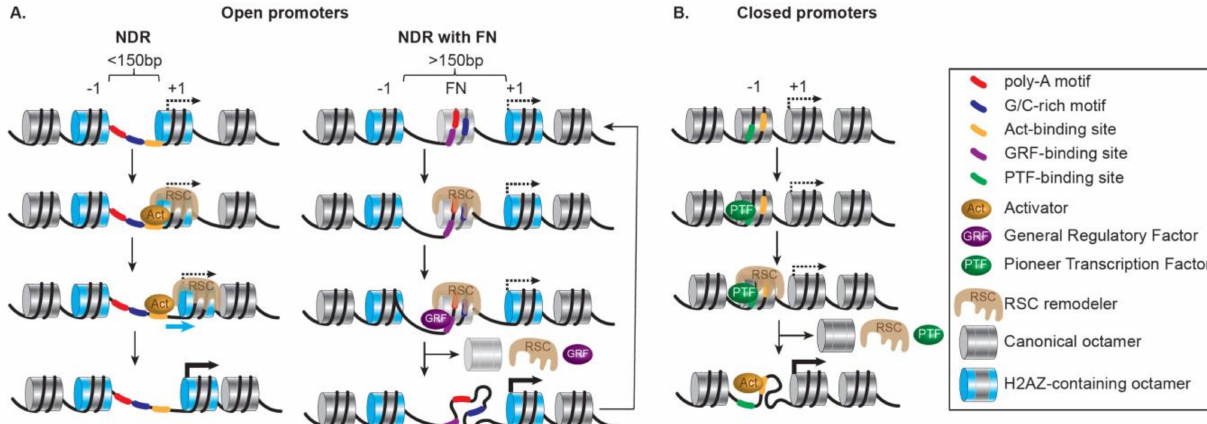
Figure 5. Promoter architectures and nucleosome occupancy impact how remodelers are recruited. For adequate regulation, most genes in yeast blend features from two types of promoter architectures. ( A ) Open promoters, in their repressed state, present an NDR without (left) or with (right) a fragile nucleosome (FN) adjacent to the TSS (black arrow), containing poly-A and G/C-rich motifs, along with activator/GRF-binding sites, and flanked by well-positioned H2A.Z-containing nucleosomes, leading to regular spacing and phasing in a genome population. Open promoters are common at constitutively active genes, and their activation necessitates minor (if any) remodeling (+1 nucleosome sliding or FN ejection) through direct remodeler recruitment by an activator or a GRF. ( B ) Closed promoters, in their repressed state, contain a continuum of canonical nucleosomes covering their TSS, leading to a genome population lacking phasing. Closed promoters are common at highly regulated genes, and their activation necessitates the binding of a pioneer transcription factor (PTF) in the nucleosomal context, followed by the recruitment of a remodeler, which opens the promoter by ejecting nucleosomes, rendering the activator-binding site